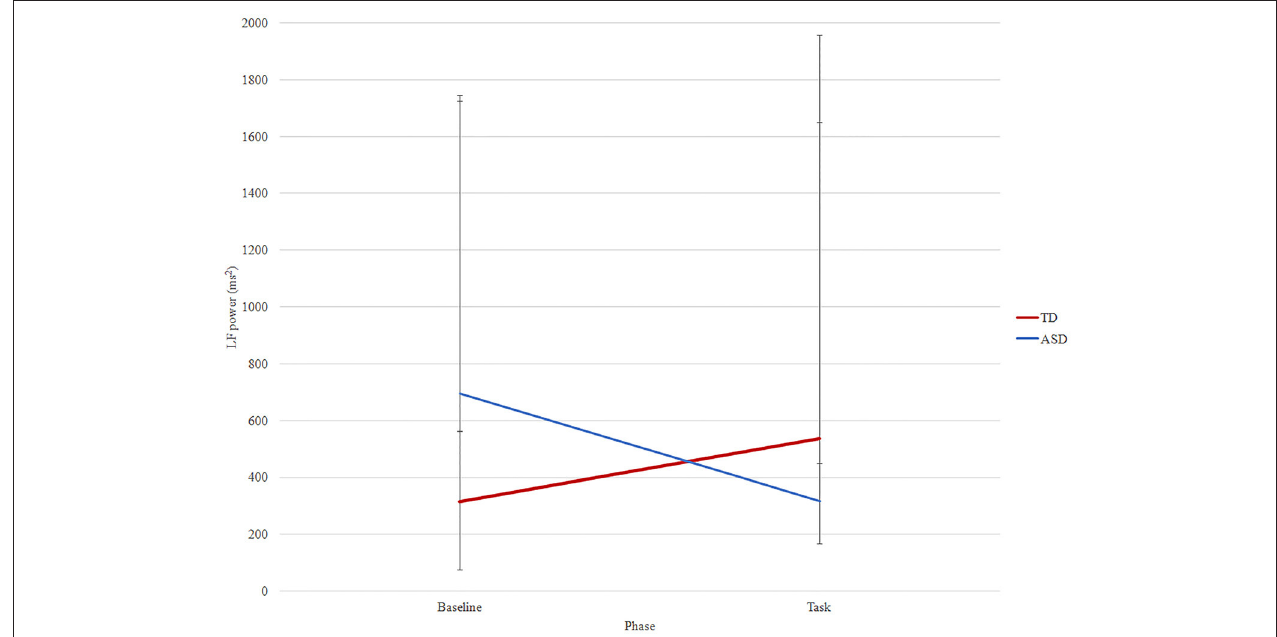
FIGURE 2 | LF changes between phases (baseline and task) in ASD (blue) and TD (red) groups. Median and interquartile are reported.